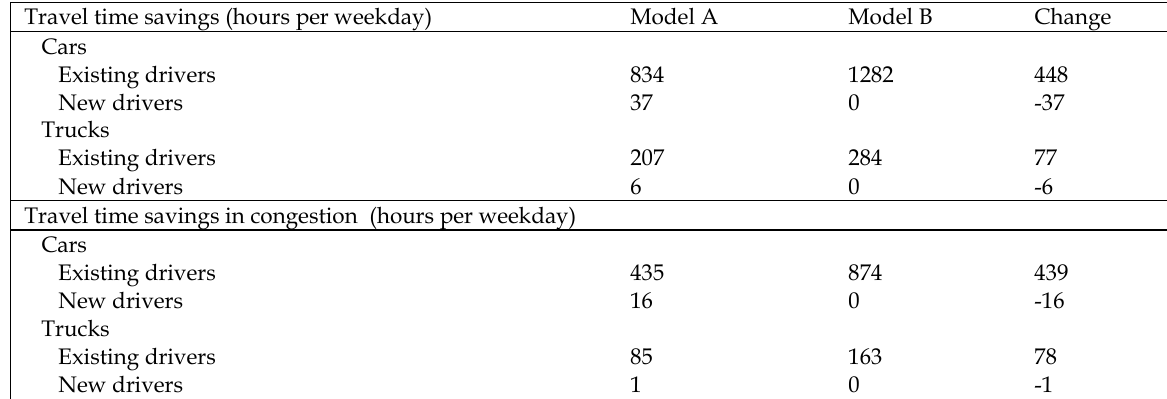
Table 2. Estimated travel time savings from the proposed Nordhavnsvej, based on transport model forecasts with induced traffic included (Model A) and ignored (Model B). Source: Tetraplan